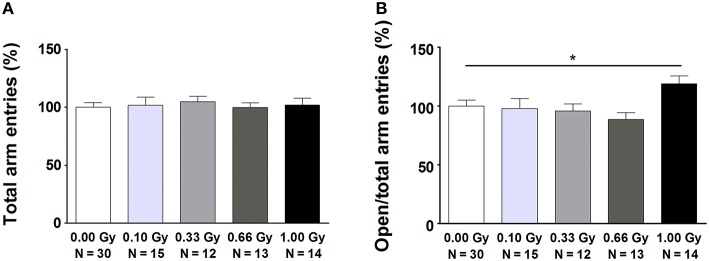
Mice irradiated in utero with 1.00 Gy spent more time in the open arms of the elevated plus maze as compared to sham-exposed animals. (A) No difference in total arm entries was found. (B) When calculating the ratio between the number of entries in the open arms in relation to the total arm entries, a significant increase was seen for the high-dose exposed mice. These results therefore point toward a decreased inhibition of irradiated mice to enter the open arms. Data are presented as mean ± SEM. Horizontal lines with an asterisks indicate significant differences between means of two groups. *P < 0.05. The number of animals used is indicated in the graphs (N). Gy: Gray.